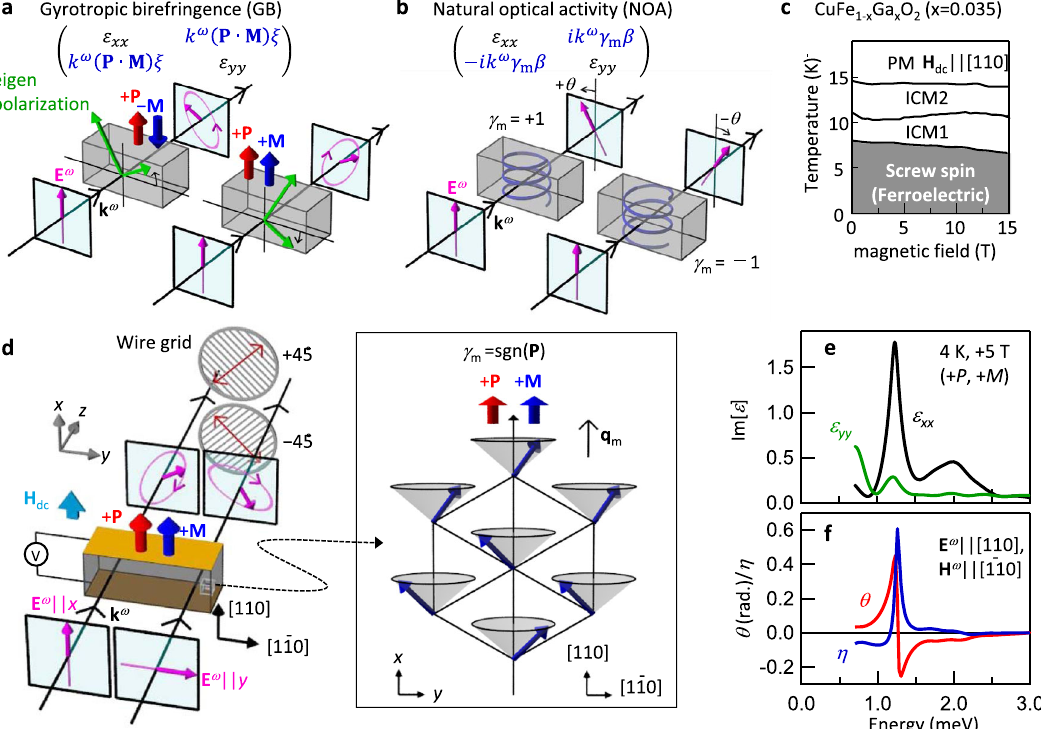
Fig. 1 Gyrotropic birefringence (GB) and natural optical activity (NOA) on electromagnon in helimagnet CuFe 1-x Ga x O 2 (x = 0.035). a The ferroelectric polarization P parallel or antiparallel to the magnetization M induces the GB. The GB response can be viewed as the rotation of eigen polarization (green arrows). The reversal of either P or M reverses the sign of the rotation of eigen polarization. The nonreciprocal optical rotation of GB is represented by the symmetric off-diagonal elements in the effective dielectric tensor. b Schematics of the optical rotation by NOA. The chiral media show the optical rotation owing to the circular birefringence/dichroism, whose sign depends on the sign of chirality γ . The antisymmetric parts of the effective dielectric tensor m represent the NOA. c Magnetic phase diagram of CuFe 1-x Ga x O 2 (x = 0.035) in the external magnetic fi eld H dc ||[110]|| q m 29 . d The schematics of terahertz time-domain polarimetry and of conical screw spin structure in the magnetic fi eld H dc ||[110]. The sign of chirality ( γ ) is rigidly connected to that of P as m γ ¼ sgn ð P Þ 29 . e Imaginary parts of ε ε fi eld (5 T) at 4 K. f Rotation angle θ and ellipticity η for the incident light with E ω ||[110]. The xx and yy in the magnetic m sample thickness is 1